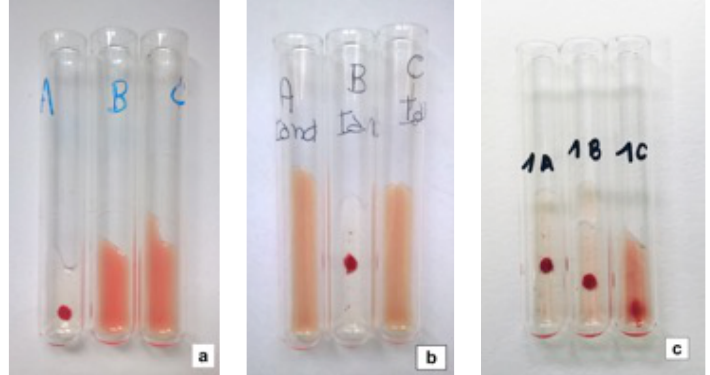
Figure 1. Type-A ( a ), B ( b ) and AB ( c ) feline blood samples analyzed with the tube agglutination technique. Blood type was determined by the presence of agglutination in the corresponding tube assigned as A or/and B and absence of agglutination in C (control) tube.